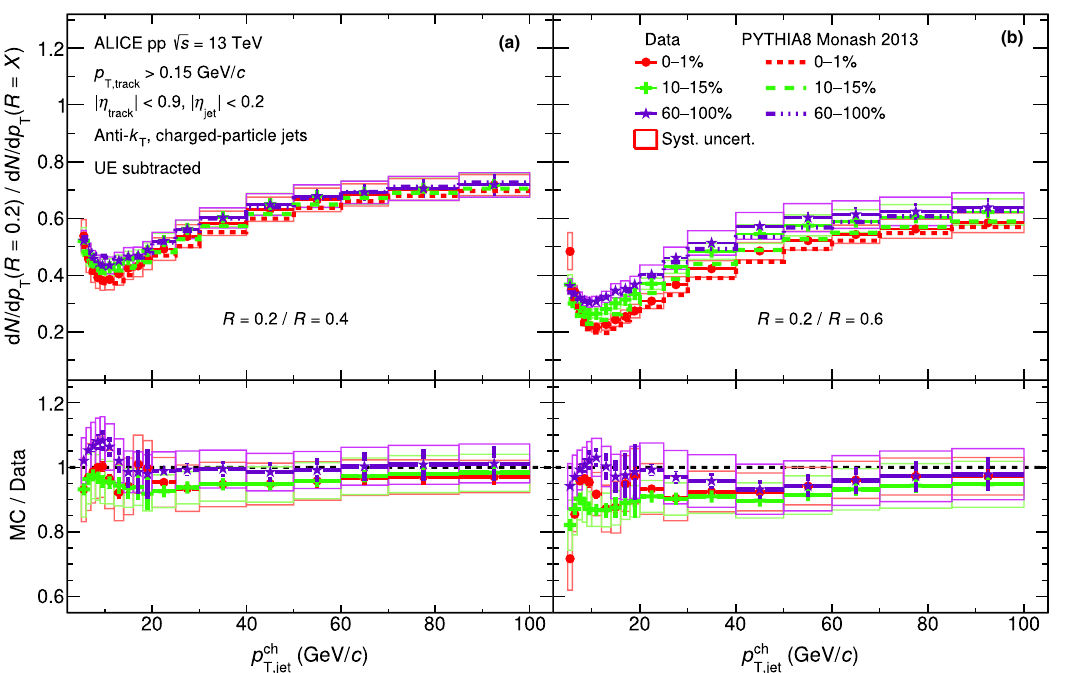
Fig. 20 Comparison of jet production ratios of R = 0 . 2 to R = 0 . 4 (a) , R = 0 . 6 (b) in three different multiplicity classes and compared with PYTHIA MC simulations. Statistical and the total systematic uncertainties are shown as vertical error bars and boxes around the data points, respectively